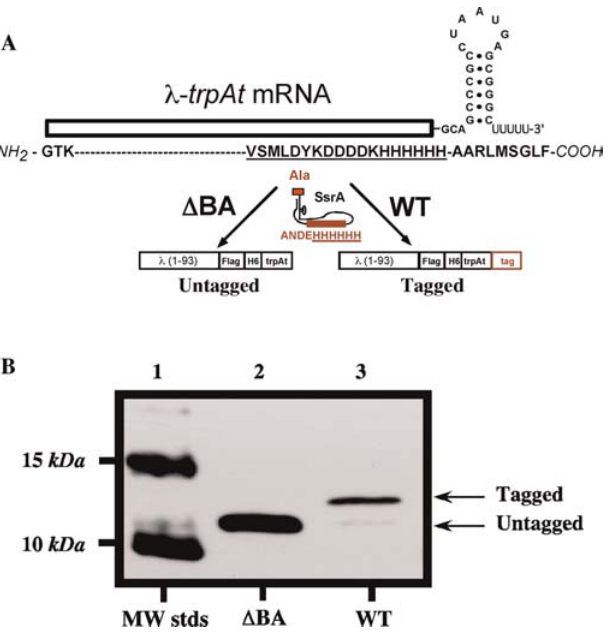
Figure 1. SmpB-SsrA Mediated Protein Tagging Activity Is Observed in Y. pseudotuberculosis (A) Schematic representation of the k -cI-N-trpAt reporter construct encoded on the pKW540 plasmid and anticipated outcomes of protein tagging in wild-type (WT) or D BA strains. (B) The k -cI-N-trpAt reporter was induced in wild-type and mutant ( D BA) strains, and protein samples were analyzed by Western blot using HRP- conjugated anti-H6 serum. MW stds, protein molecular weight standards. DOI: